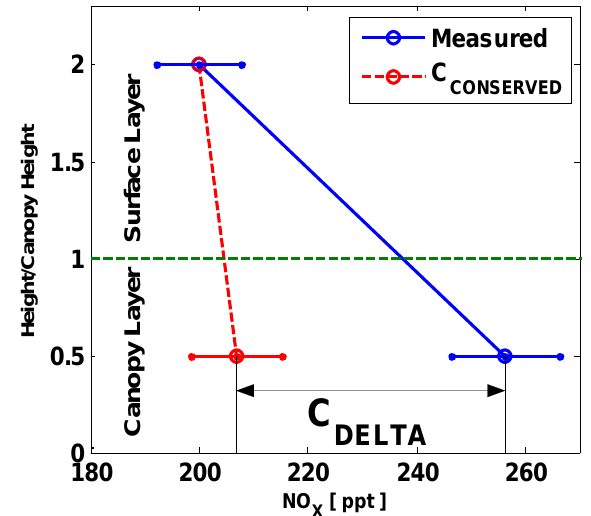
Figure 11. The estimated concentration, C CONSERVED , (red) using standard flux–gradient similarities of NO x at midday (12:00–14:00) and the measured vertical gradient (blue) giving values for C DELTA of 54 ppt (NO x ). Open circles and whiskers are the mean and standard errors.